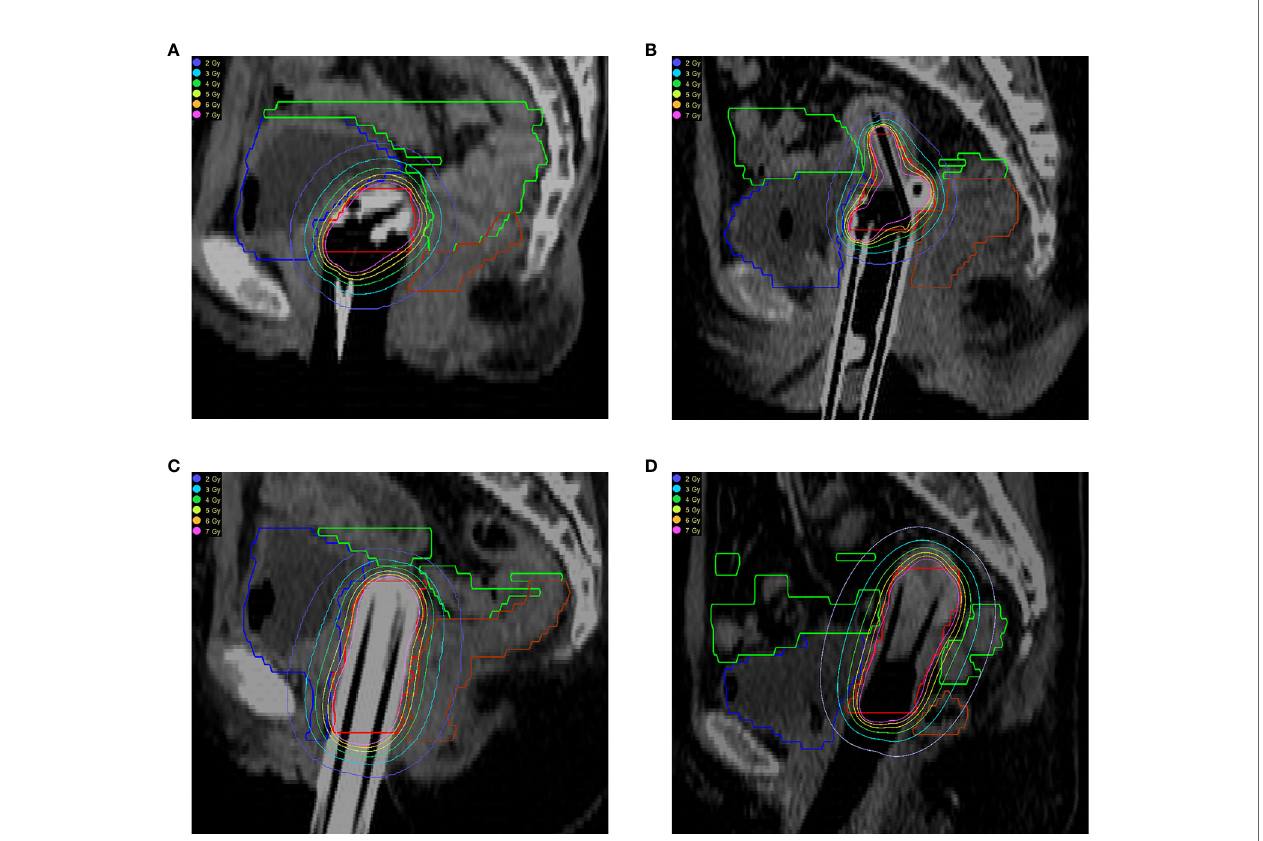
FIGURE 1 | Isodose line of patients using different applicators. (A) Double ovoid applicator; (B) Tandem-ring applicator; (C) Multi-channel applicator; (D) Tandem- needles. The organs are HR-CTV (red), bladder (blue), rectum (brown), and sigmoid